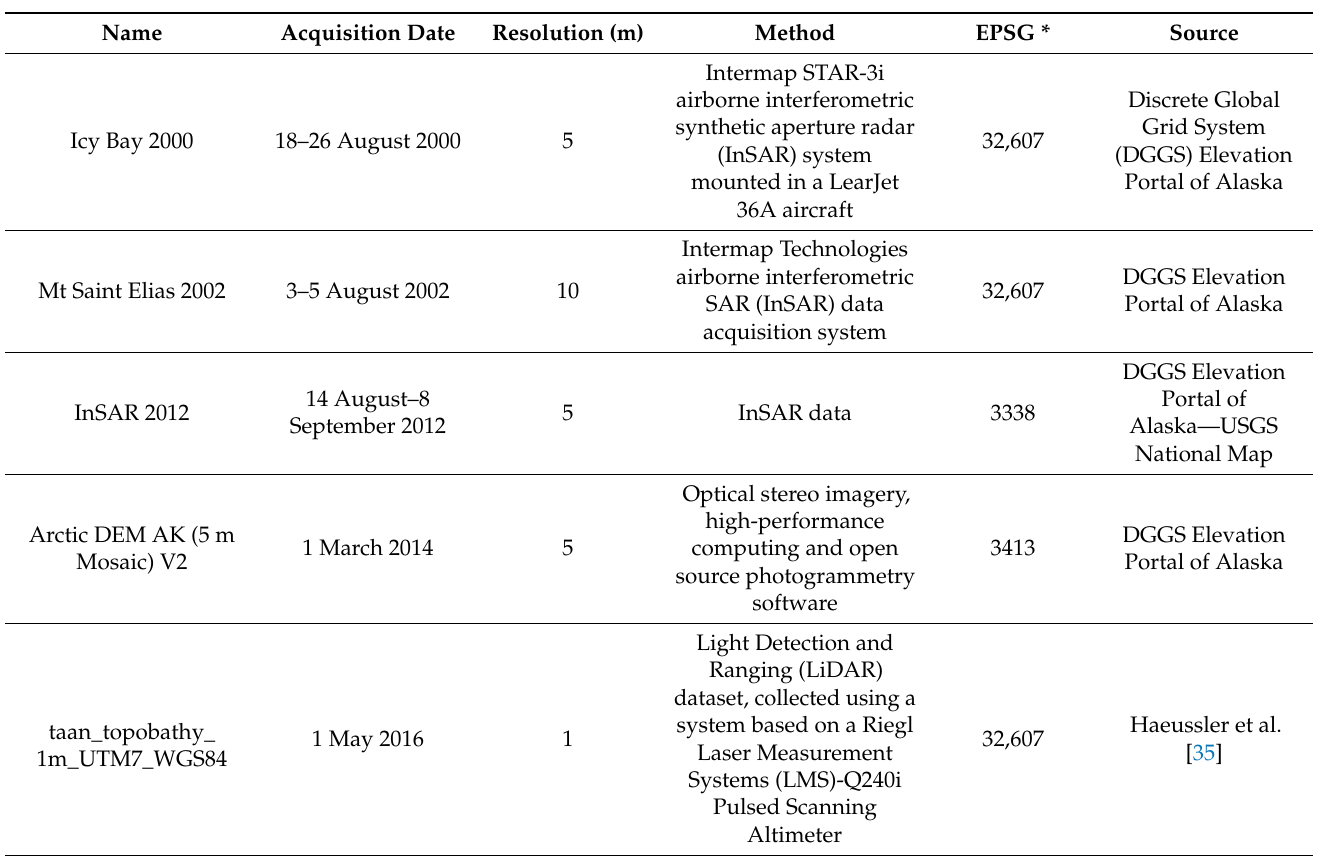
Table 1. Summary of the Digital Elevation Models (DEM) and related information from different sources (modified from Franco et al.